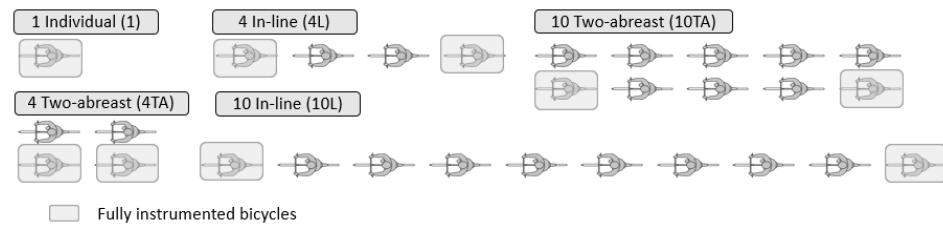
Figure 2. Cyclists group configurations.